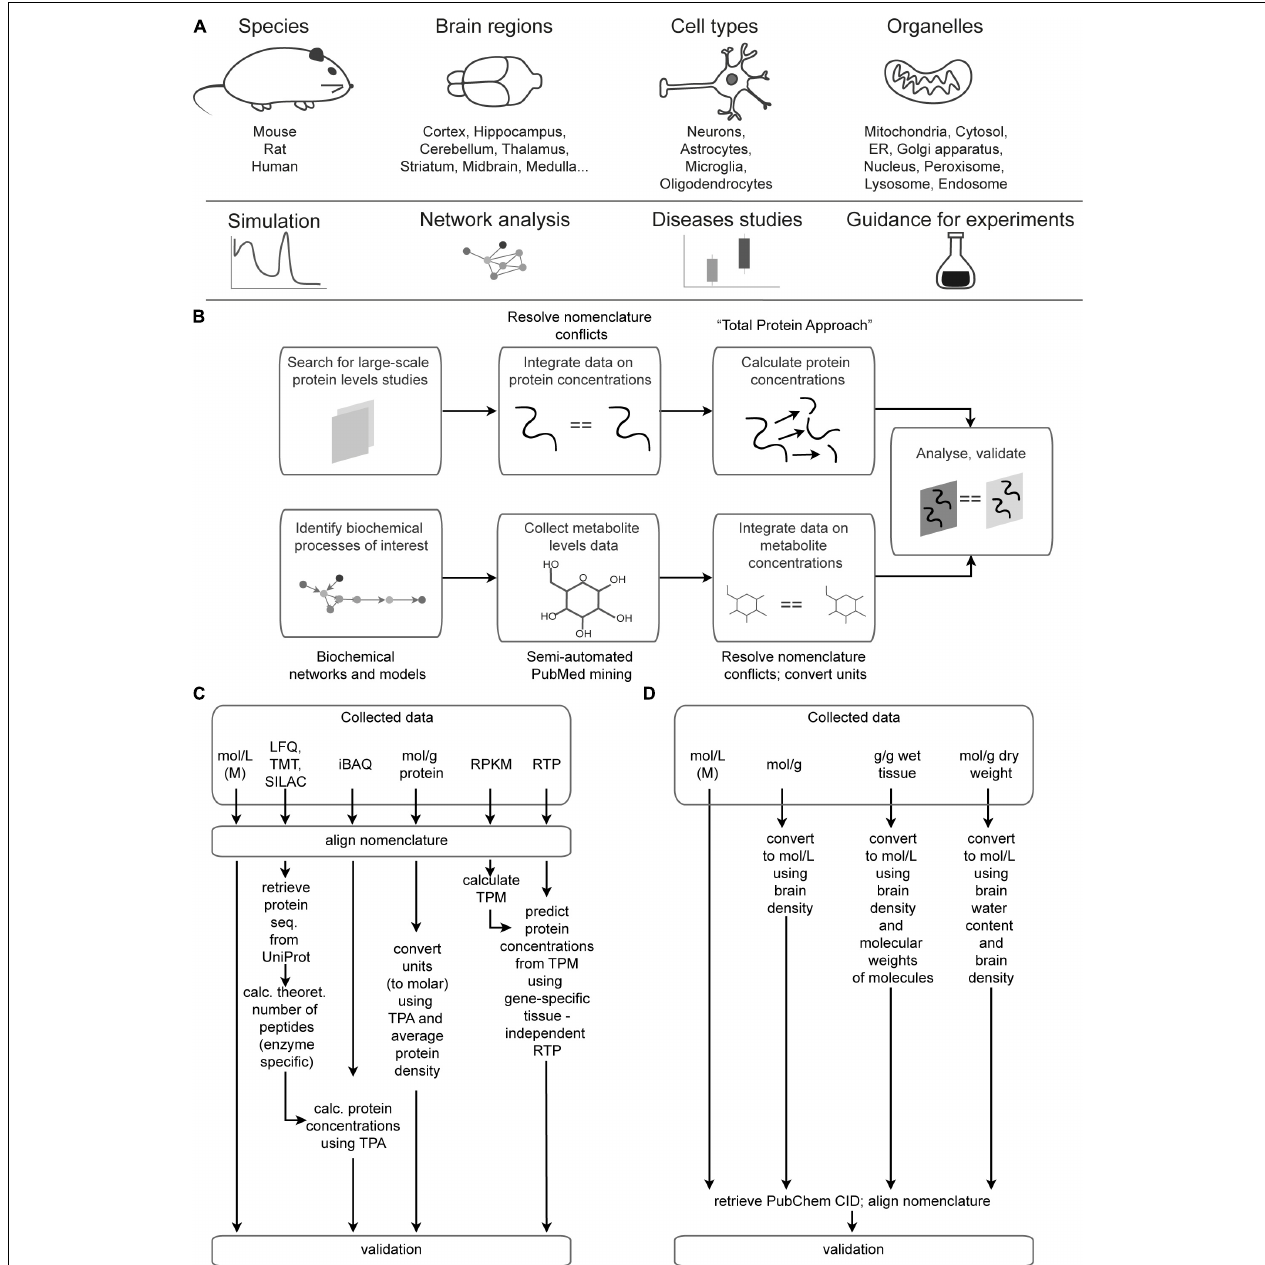
FIGURE 1 | Data scope overview and integration pipeline. (A) Scope and potential applications of data integrated in the Brain Molecular Atlas. (B) General pipeline for the Brain Molecular Atlas data integration. (C,D) Detailed pipeline for calculating protein (C) and metabolite (D) concentrations. Abbreviations: ER = endoplasmic reticulum, LFQ = label-free quantification; TMT = tandem mass tag; SILAC = stable isotope labeling by/with amino acids in cell culture; iBAQ = intensity-based absolute quantification; RPKM = reads per kilobase million; TPM = transcripts per kilobase million; RTP = RNA to protein ratio estimator; CID = compound ID